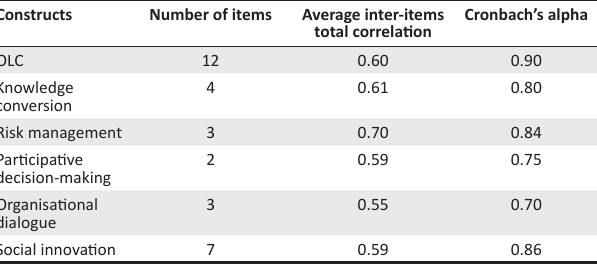
TABLE 1: Reliability results for the remaining organisational learning capability factors and the social innovation